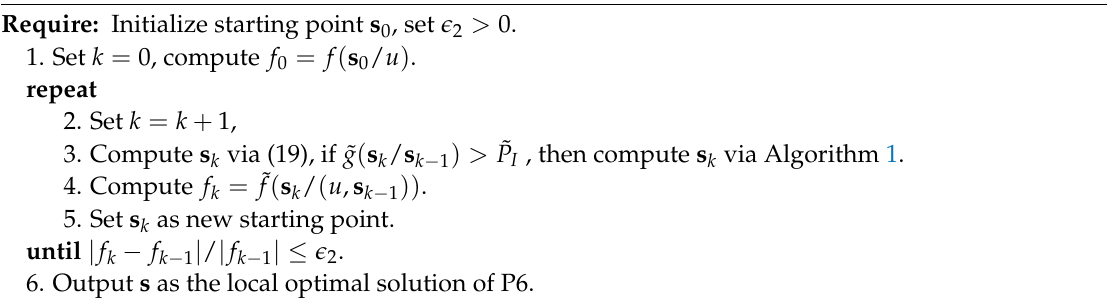
Algorithm 2 ( (Minorization–maximization (MM) algorithm to solve